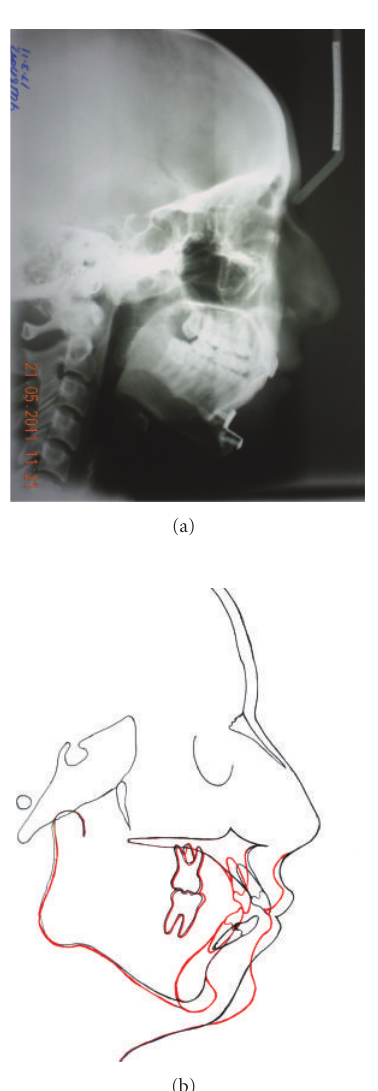
Figure 7: (a) Postgenioplasty cephalogram, (b) pre-and posttreat- ment